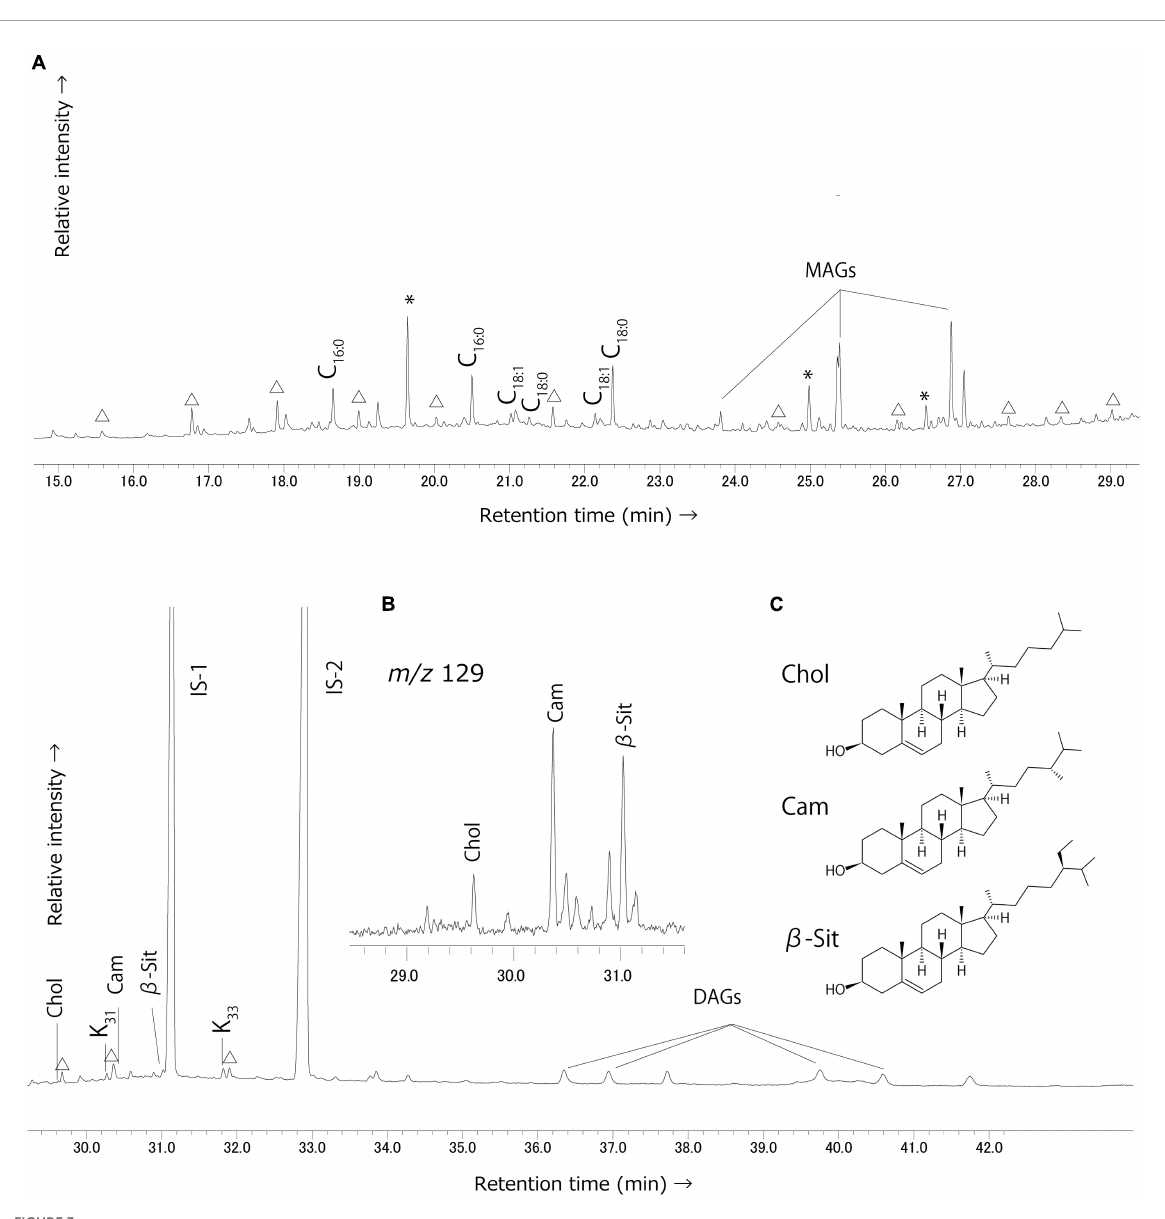
FIGURE3 Typical partial gas chromatogram of the Tortoba potsherd (TOR001ITLE) lipid extract. (A) Partial total-ion chromatogram of the solvent extracts. Peak identities–Cx:y: saturated fatty acids with x carbon length and number of unsaturations y, (cid:77) : n -Alkanes, *plasticizer contamination. MAGs, monoglycerides; DAGs, diglycerides; IS-1, n -tetratriacontane; IS-2, n -hexatriacontane. (B) The summed m/z 129 ion chromatogram shows the presence of sterols. (C) Chemical structure of the Cholesterol, Campesterol, and β